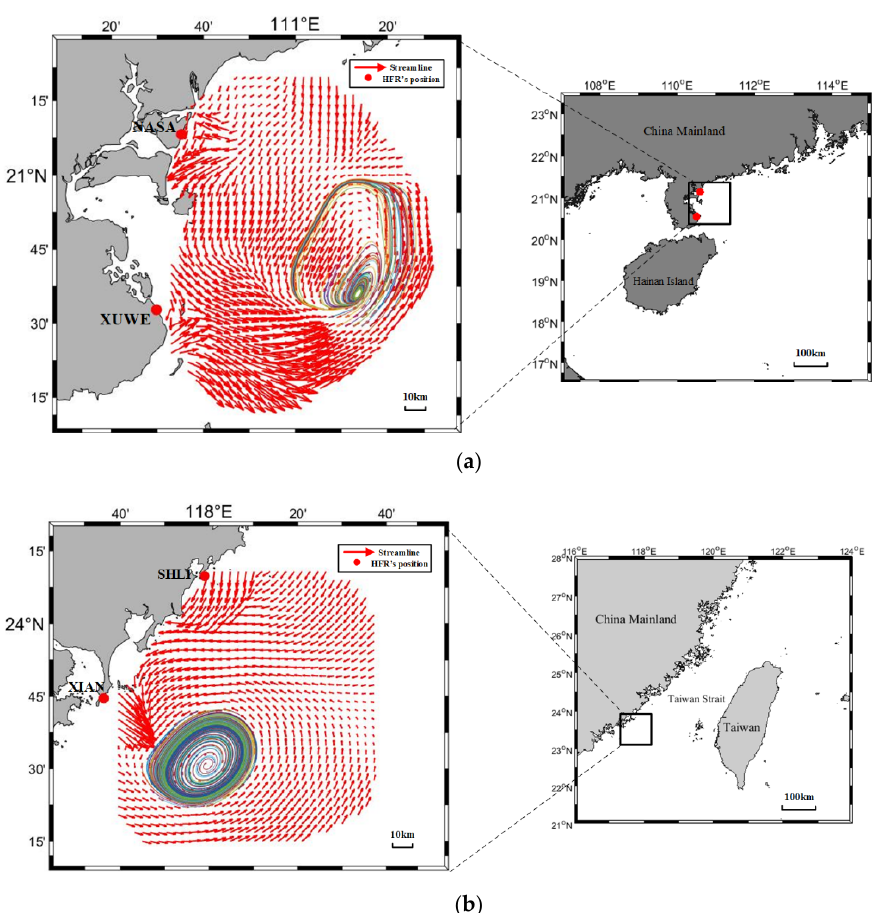
Figure 1. Two different observation regions of Ocean State Monitoring and Analyzing Radar, model S (OSMAR-S). ( a ) Taiwan Strait and ( b ) South China Sea. The left columns are the observation results. The red arrows represent current and color lines show the eddy’s streamlines. The red spots denote the high-frequency radar (HFR) sites. The right columns are the wide view of the observation